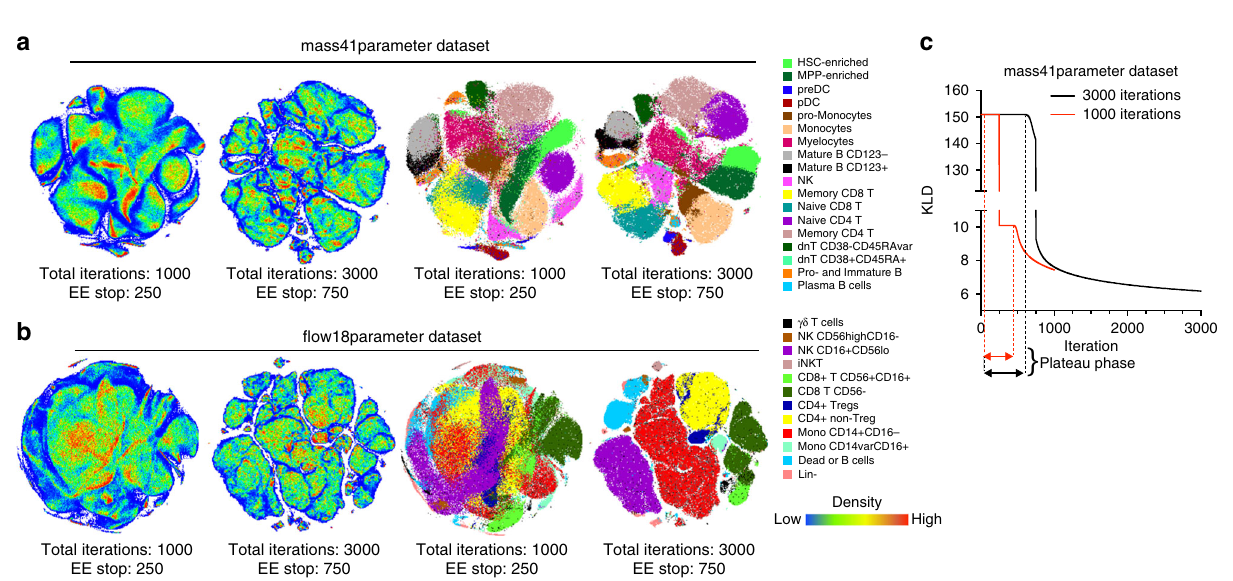
Fig. 1 Performance of Barnes-Hut t-SNE implementation for cytometry data visualization. Standard (1000 iterations) and extended (3000 iterations) embeddings of mass cytometry ( a ) or fl ow cytometry ( b ) data are presented as heatmap density plots (left) or color-coded population overlays based on ground-truth classi fi cation of single cell in the datasets (right). c KLD change over iteration time of gradient descent for standard 1000 iterations (red line) or extended 3000 iterations (black line) embeddings of mass41parmeter dataset. Representative examples of multiple runs with varying seed